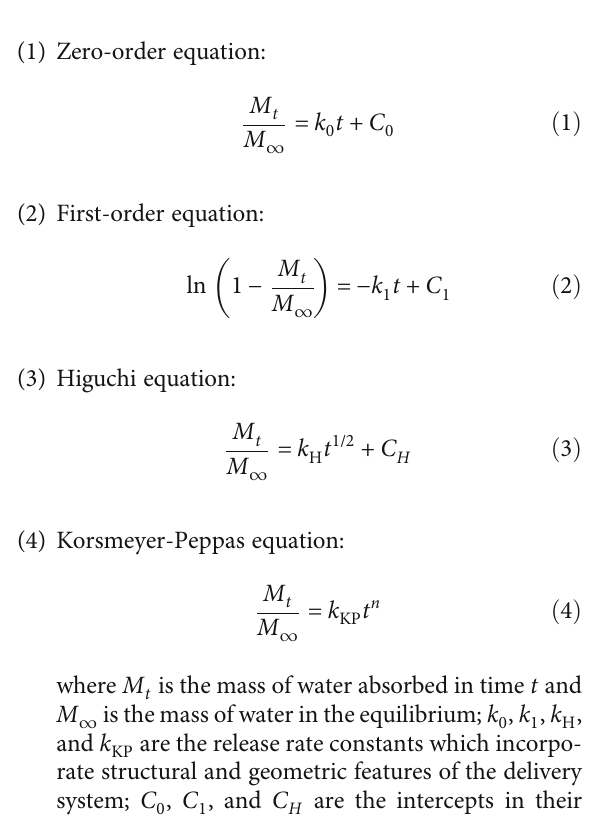
Figure 1: Drug Delivery System as patch: (a) the patch is removed from its protective membrane; (b) the patch is placed on the body; (c) phase of drug release, e.g., the release can be activated by stimuli as temperature or